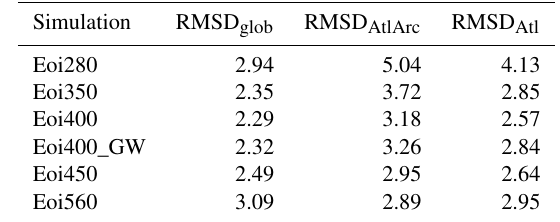
Table 6. Root mean square deviation (RMSD) between simulated and reconstructed (PRISM3; Dowsett et al., 2009, 2013) sea sur- face temperature. Model data are derived at a core location by bi- linear interpolation. We present global RMSD (RMSD glob ) con- sidering all available reconstruction sites, North Atlantic to Arc- tic Ocean RMSD (RMSD AtlArc , considering reconstructions north of 30.00 ◦ N and between 70.00 ◦ E and 8.25 ◦ W), and North At- lantic Ocean only RMSD (RMSD Atl , considering